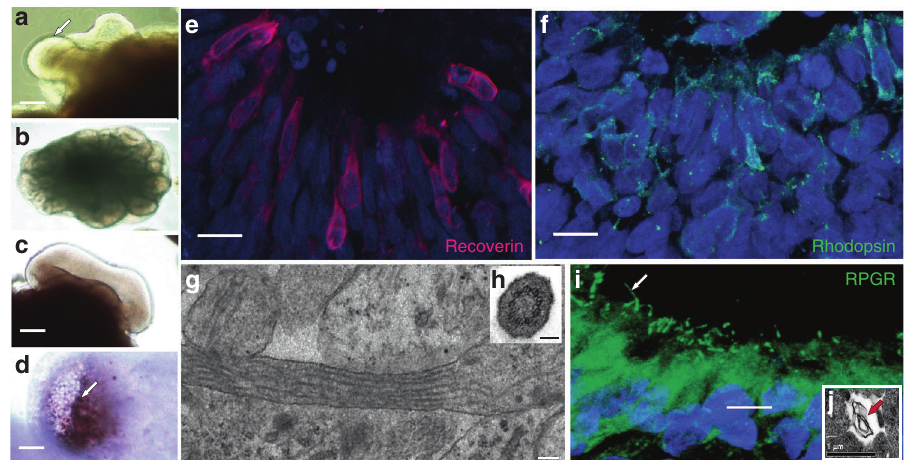
Fig. 1 Three-dimensional patterning of induced pluripotent stem cells produces mature photoreceptors. Free fl oating aggregates grown using a retinal differentiation protocol 10, 11 self-organise into budding spheroids with a single bud shown in a ( arrow ) and multiple buds from one spheroid in b . Buds invaginate ( c ) to form optic cups which mature over 100 days ( d ). Pigmented retinal pigment epithelium (RPE) emerges externally ( arrow ; d ) while a radial arrangement of Recoverin ( e ) and Rhodopsin ( f ) expressing photoreceptors organise internally, forming an outer nuclear-like layer. Electron microscopy studies reveal a classic “ 9 + 0 ” microtubule doublet formation in these cilia ( g , inset h shows cross-section). RPGR is present in photoreceptor cilia ( arrow ; i ) whilst electron microcopy shows the production of membranous material, as required for outer segment formation ( arrow , j ). Scale bars : 400 μ m ( b